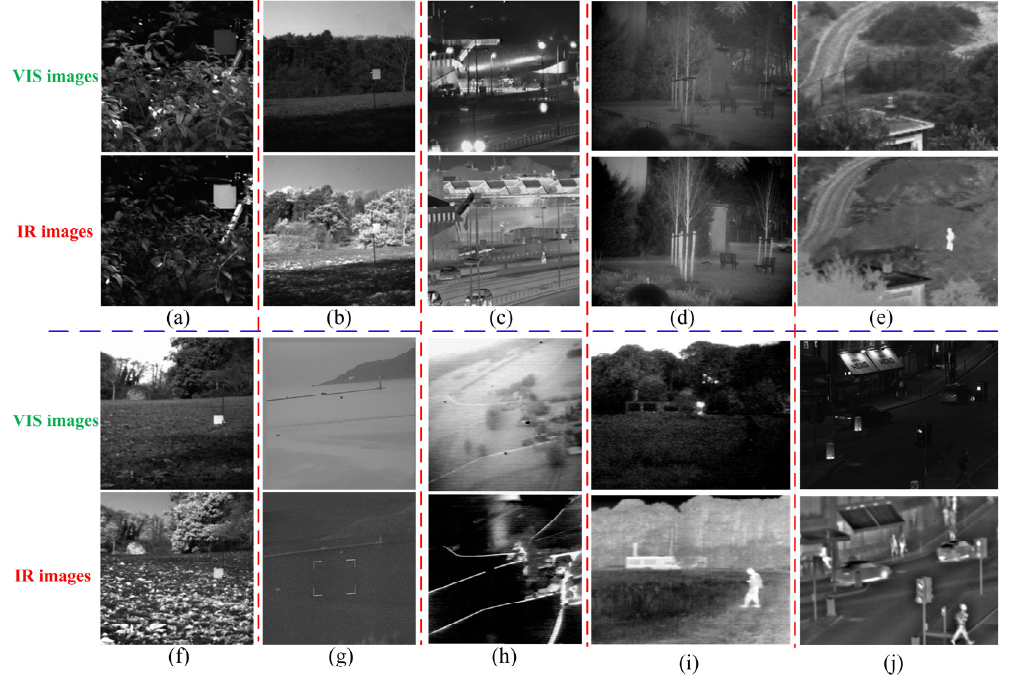
Figure 8. Source images. ( a – j ) are the ten pairs of VIS/IF images